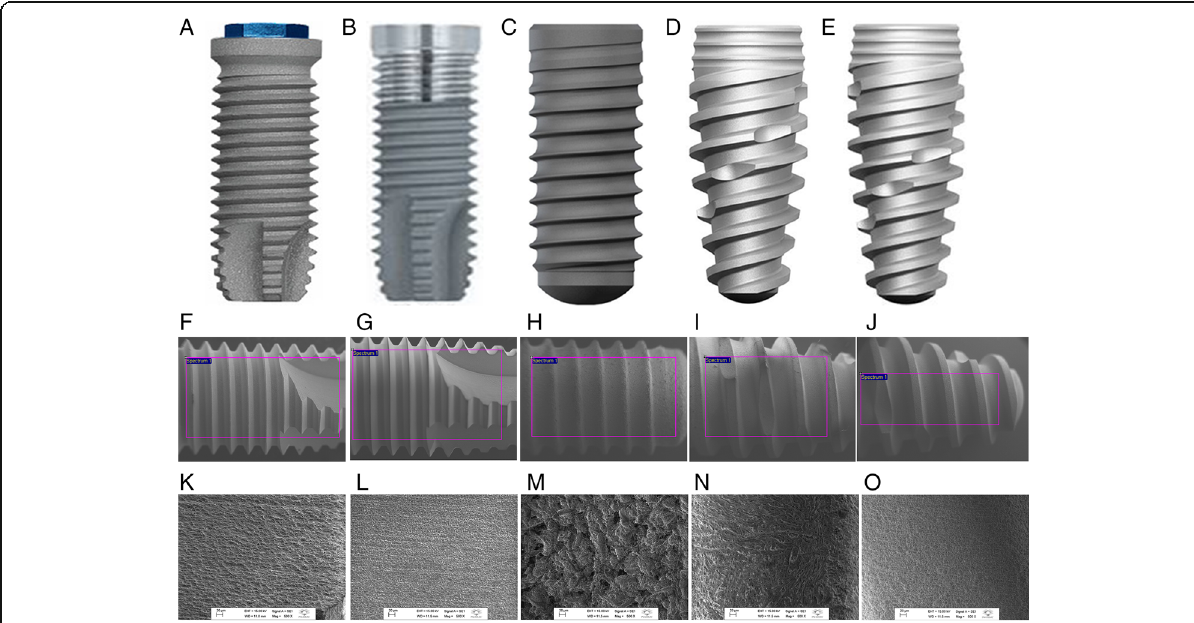
Fig. 1 General features and macrogeometry of each model of dental implant evaluated (Macrogeometry and SEM images; × 500 magnification).